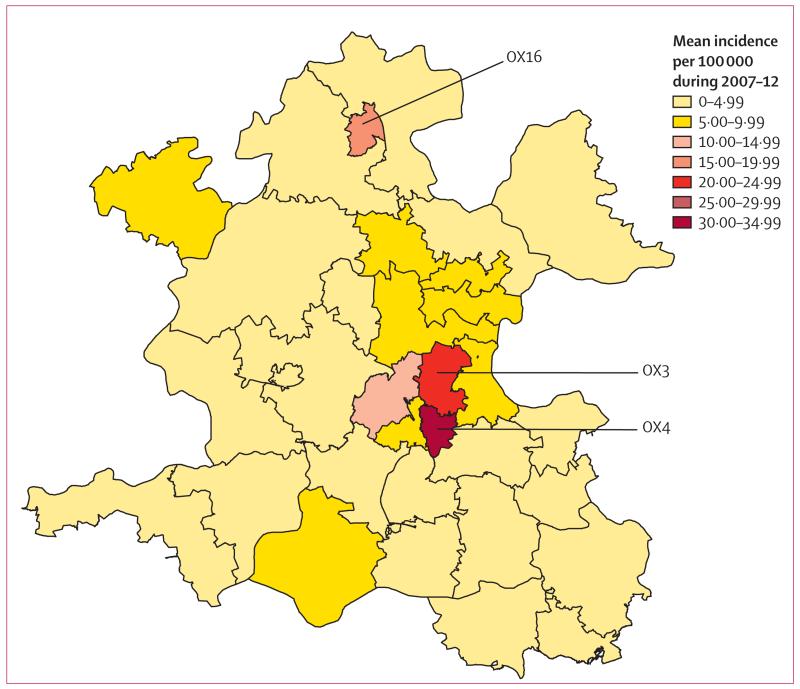
Mean tuberculosis incidence in Oxfordshire (2007–12)Map based on 383 of 384 cases: the postcode for one patient was unknown. Crown copyright and database rights 2013 Ordnance Survey 100016969.